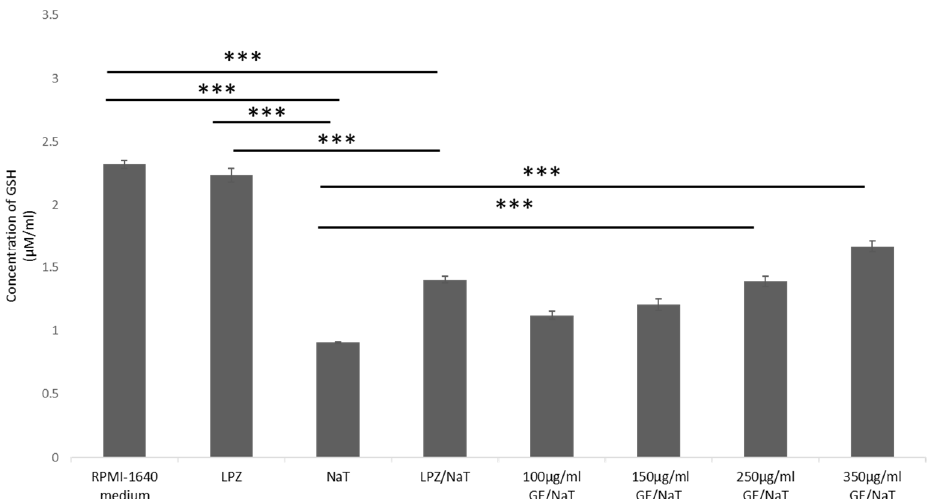
Figure 3. Effects of GE pretreatment on the levels of GSH in AGS cell line. GSH measurements were carried out by spectrophotometry at 415 nm. One way ANOVA F(7,23) = 72.99; p = 5.99 × 10 − 11 ; post hoc Tukey HSD. The values are represented in micromole per milliliter as average with standard deviation ± SD. Bars assigned with asterisks are statistically significantly different (*** p < 0.001) The data shown are representative of at least three independent experiments. Cellular glutathione (GSH), human gastric cell line (AGS), sodium taurocholate (NaT/4 mM), lansoprazole (LPZ/10 µ M), garlic extracts (GE/100, 150, 250 and 350 µ